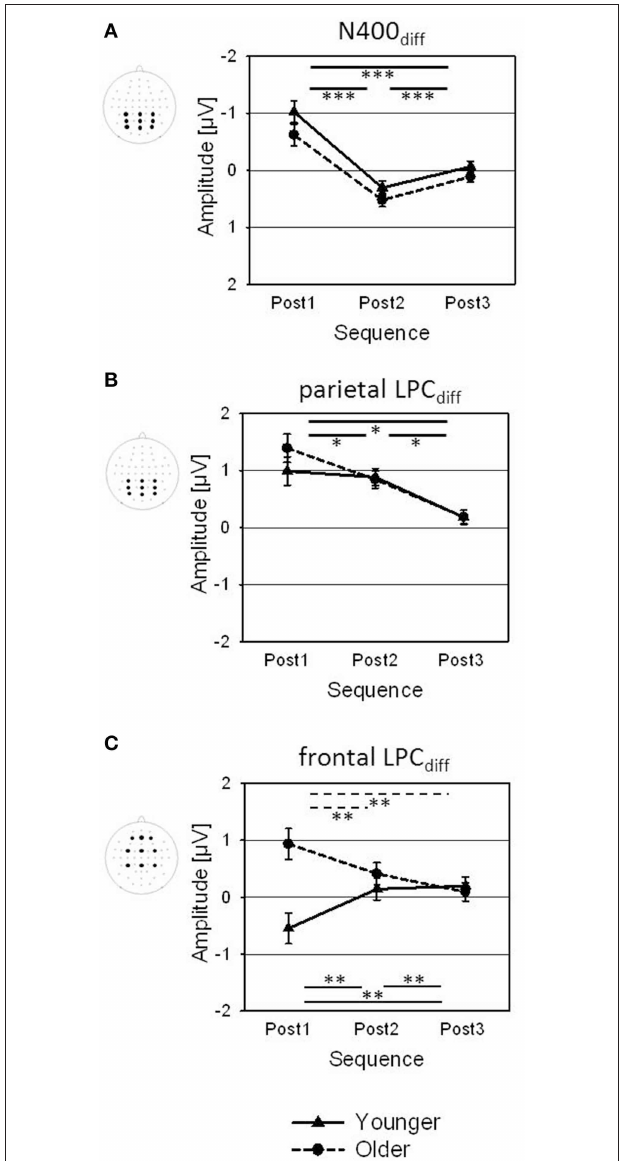
FIGURE 6 | Amplitudes of the change-related ERPs [(A) N400 diff , (B) parietal and (C) frontal LPC diff ; averaged across the displayed electrode arrays] for Post1, Post2, and Post3 sequences, shown for younger and older participants. Error bars are standard errors across participants ( N = 22 ). Significance bars and asterisks indicate significant differences between sequences in the younger group (solid), in the older group (dotted), or averaged across both groups (bold; * p < 0.05 ; ** p < 0.01 ; *** p < 0.001 ).